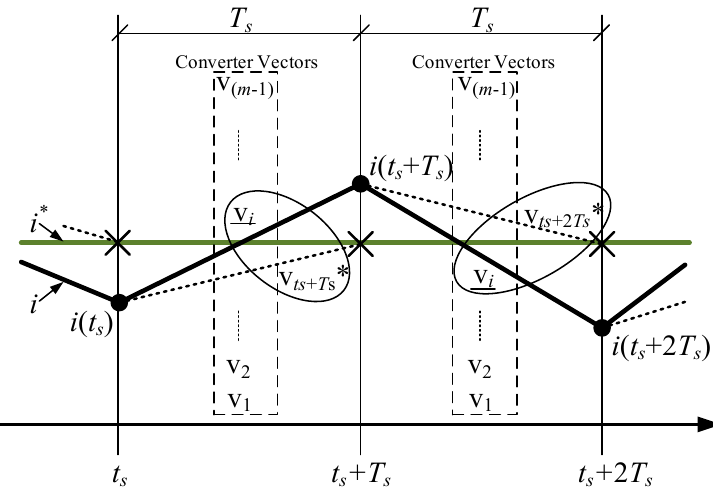
Figure 3. Illustration of the backward Euler stabilized control strategy.